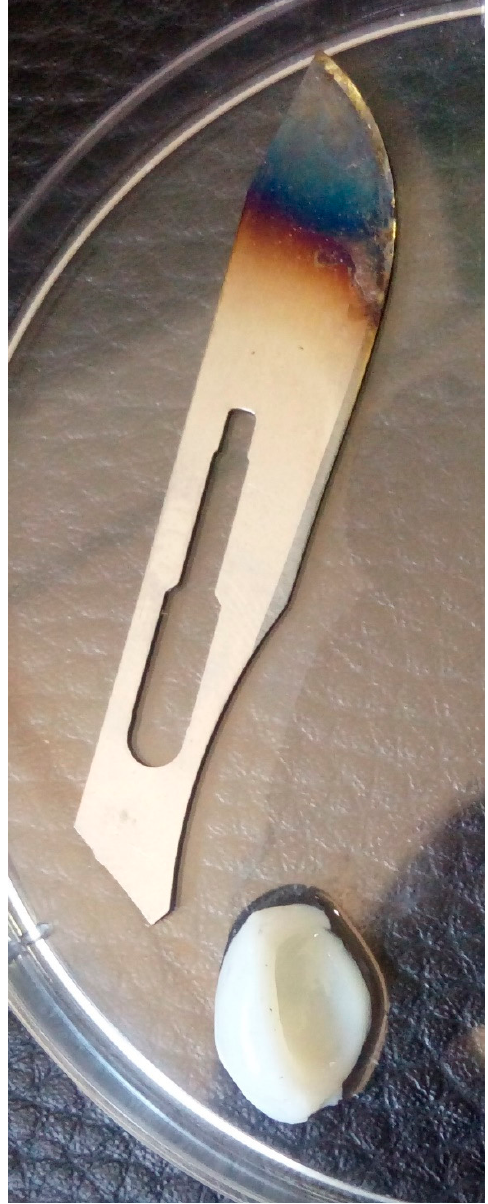
Figure 1. Oral abscess sample separated from the Ball Python mouth. Gram-negative bacilli were isolated from the abscess samples and the identities of the isolates were confirmed by biochemical tests. Antibiotic susceptibility of the isolates